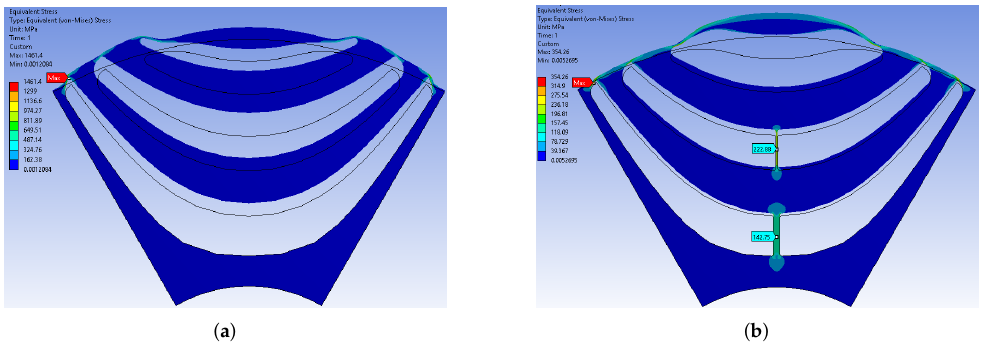
Figure 11. Mechanical stress distribution of the designed SynRM rotors at the speed of 10,230 rpmL: ( a ) The optimized SynRM rotor; ( b ) The optimized SynRM rotor with central